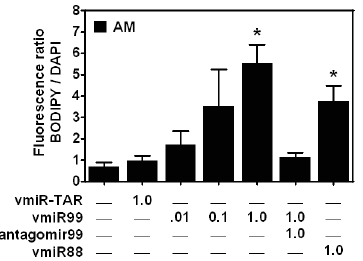
Figure 8. Foam cell formation is induced by HIV vmiR99 in alveolar macrophages in a dose-dependent manner and is inhibited by antagomir99. Alveolar macrophages were plated and pretreated with different doses of antagomir99 followed different doses of HIV vmiR99 and incubated for 24 h and stained with BODIPY 493/503 and DAPI. Results are representative of four independent experiments with similar results. (Fig. 2K). Taken together, GU-rich ssRNA from HIV is sufficient to induce foam cell formation in macrophages and the effect is specific because when uridine was replaced with adenine this response is lost. These results suggest that increases in foam cell formation by HIV ssRNA could be the result of HIV-induced inflammation.